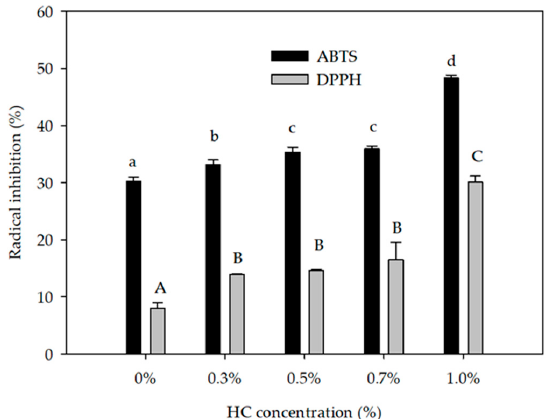
Figure 3. Antioxidant activity by ABTS (2,2 ′ -Azino-bis(3-ethylbenzothiazoline-6-sulfonic acid)) and DPPH (2,2 diphenyl-1-picrylhydrazyl) radical inhibition of the whey beverage with different concentrations of added hydrolyzed collagen (HC). Values are means ± SD based on 3 observations. Means within the same category (i.e., ABTS or DPPH) with different letters differ ( p ≤ 0.05).